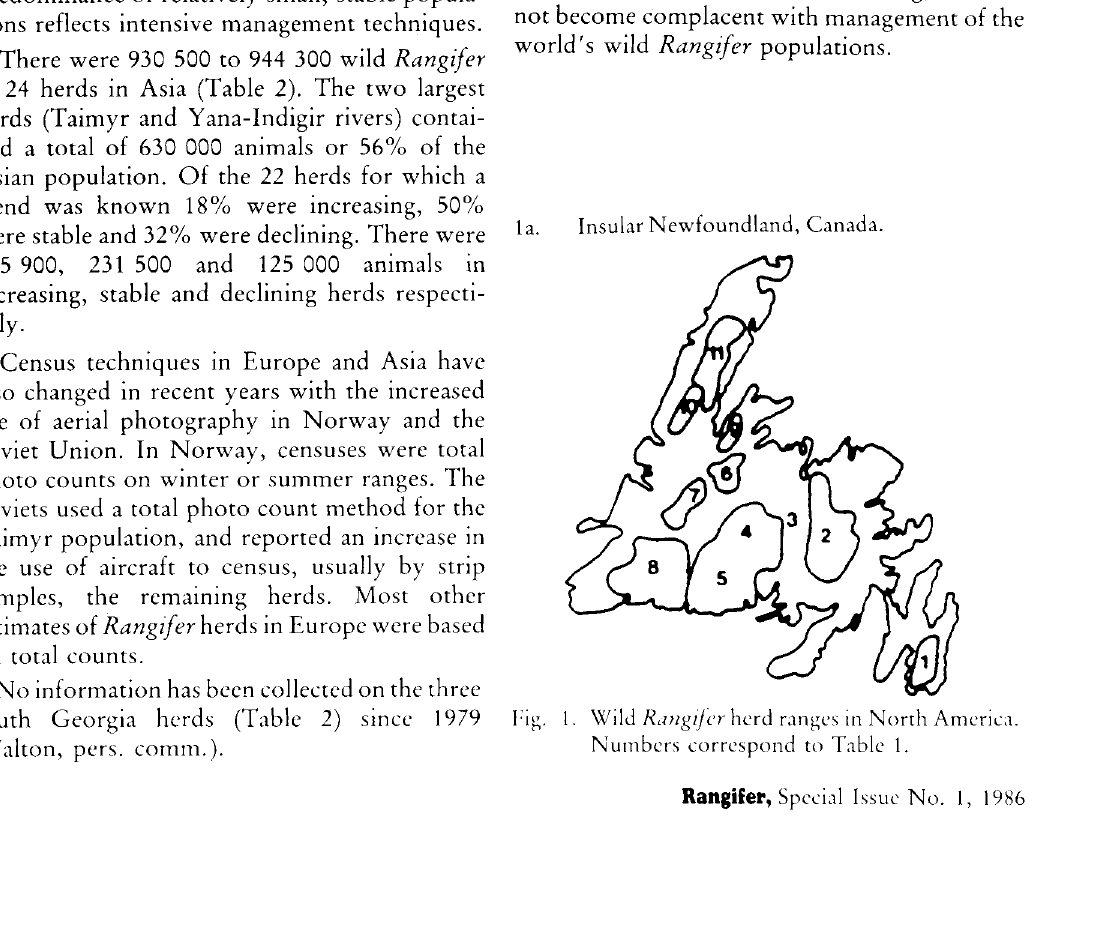
Fig. 1. Wild Rangifer herd ranges in North